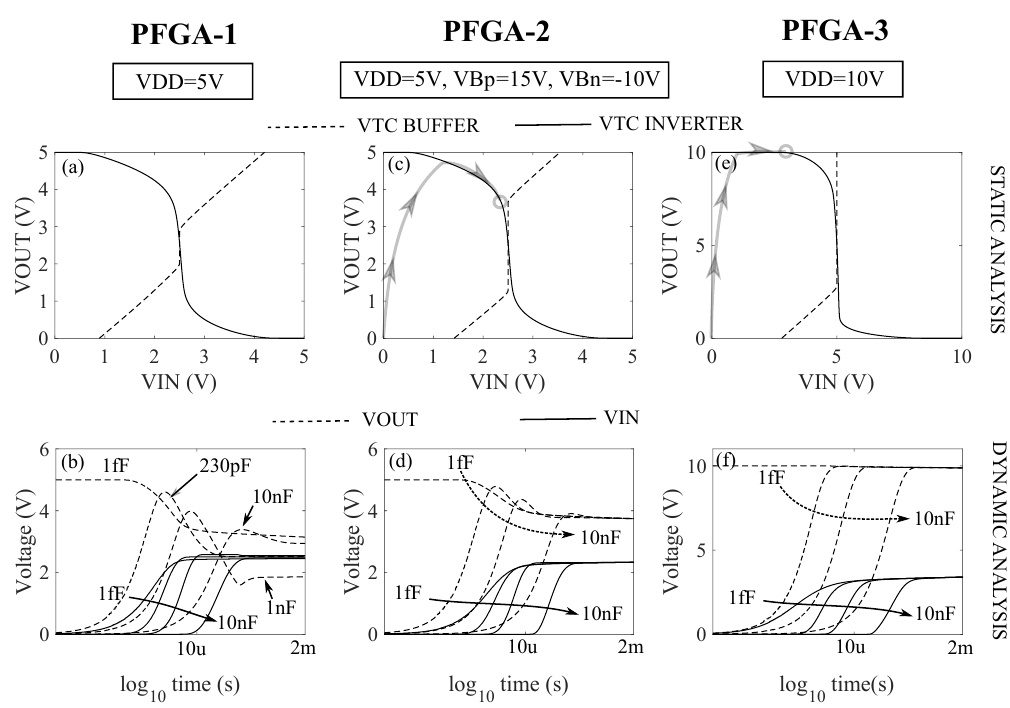
Figure 5. Comparison of three possible PFGA designs. ( a ) Graphical representation of the equilibrium point for a PFGA implemented with nmos4/pmos4 at V DD = 5 V. ( b ) Initial transient analysis of the PFGA described in ( a ) with C IN = 500 pF and sweep in value of C L . ( c ) Graphical representation of